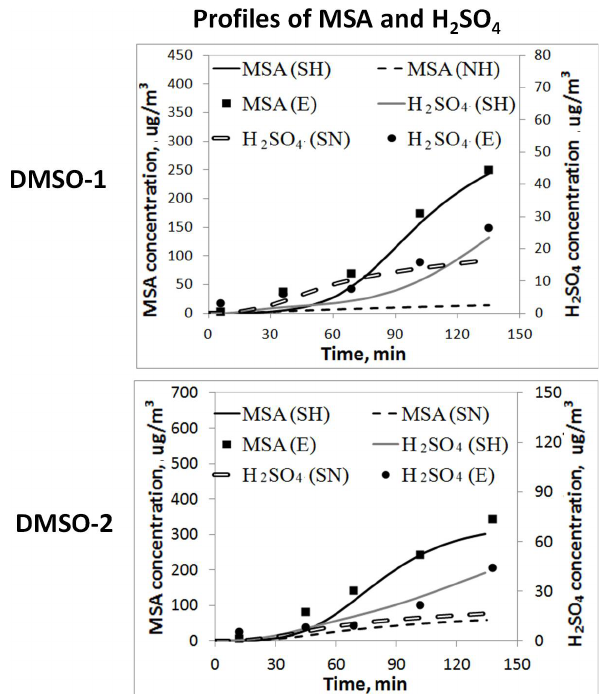
Fig. 2. Model simulation of MSA and H 2 SO 4 for the photooxida- tion of DMSO in the presence of NO x (Exp DMSO-1 and DMSO-2 in Table 1) with (SH) and without (SN) including aerosol-phase re- actions. The experimentally observed concentrations (E) of MSA and H 2 SO 4 are shown as comparison. The production of MSA and H 2 SO 4 was corrected for wall